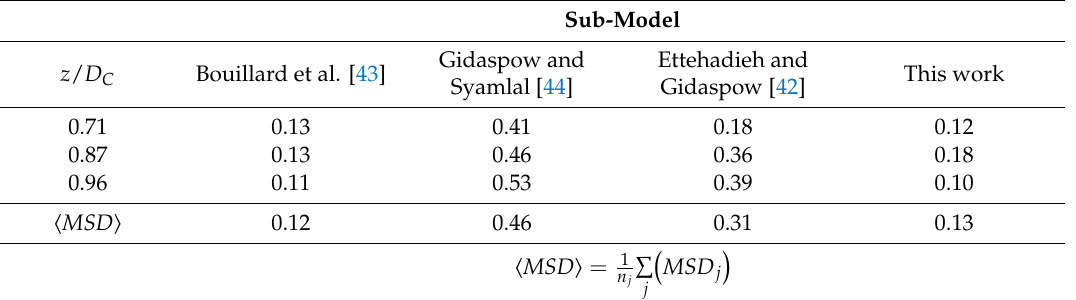
(cid:68) (cid:69) V β / V ms = 0